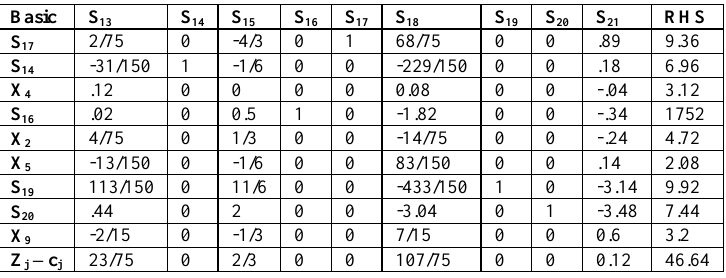
Table 3. Basic variables, solution and B -1